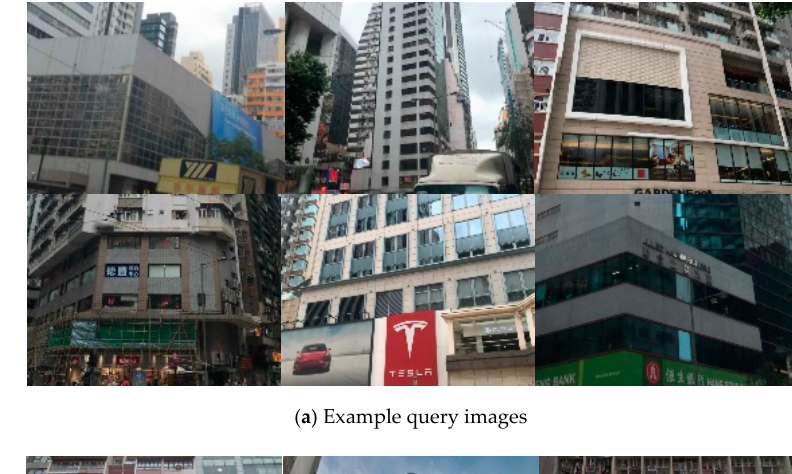
Figure 7. The distribution of street view images.